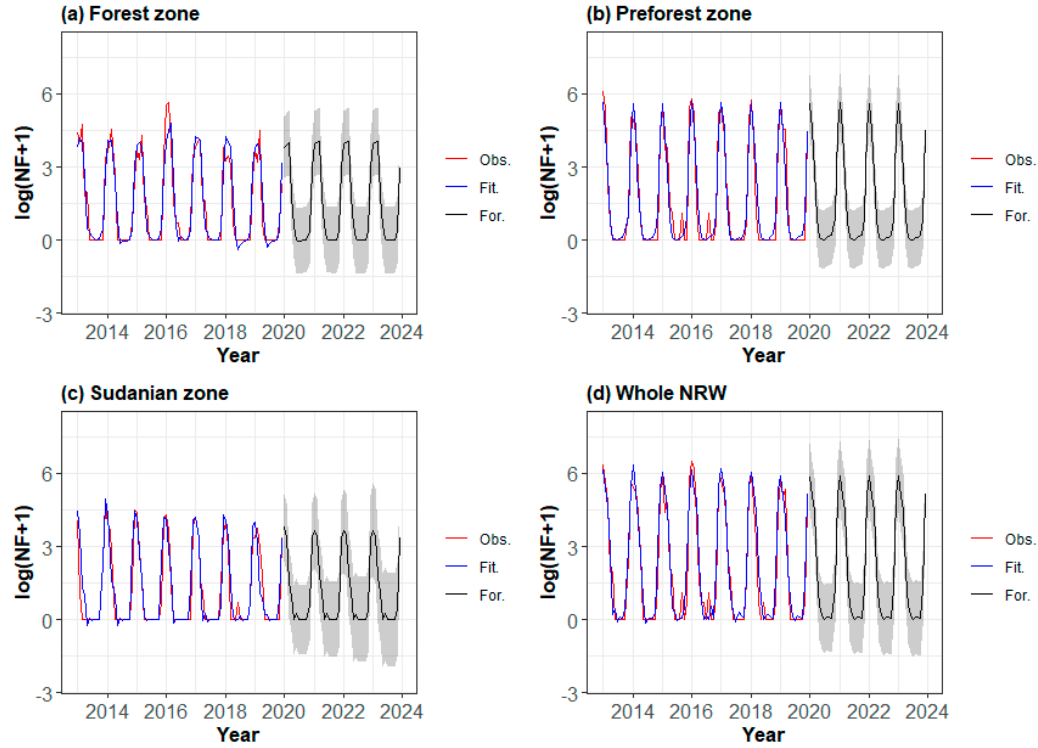
Figure 7. Forecasts from the seasonal ARIMA (SARIMA) models applied to the number of wildfires in the (a) forest zone, (b) pre-forest zone, (c) Sudanian zone, and (d) whole NRW. the ( a ) forest zone, ( b ) pre-forest zone, ( c ) Sudanian zone, and ( d ) whole